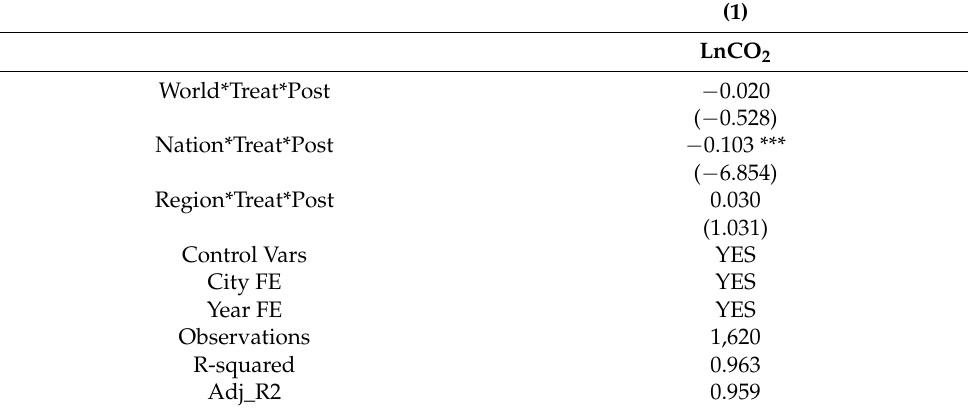
Table 7. The effect of city cluster policy on CO 2 emissions across city cluster positioning